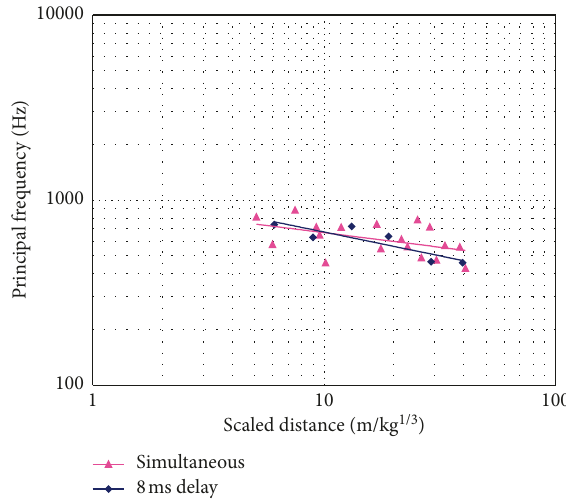
Figure 9: PFs between simultaneous and 8ms delay